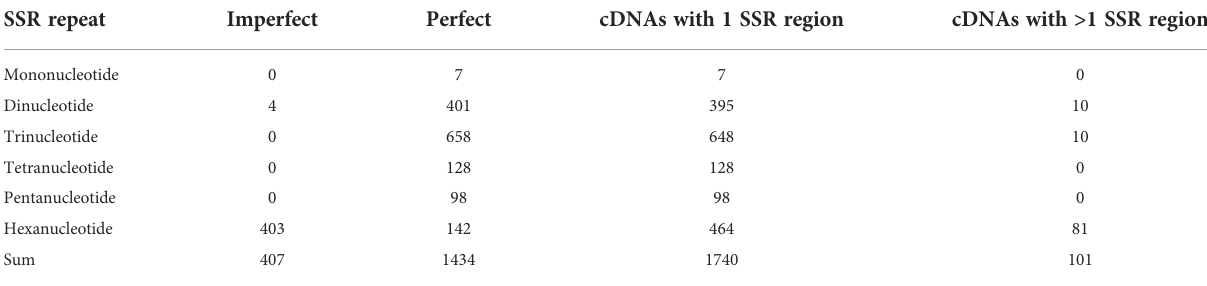
TABLE 3 Distribution of perfect and imperfect SSRs, and cDNAs with 1 or more SSR regions in different types of repeated